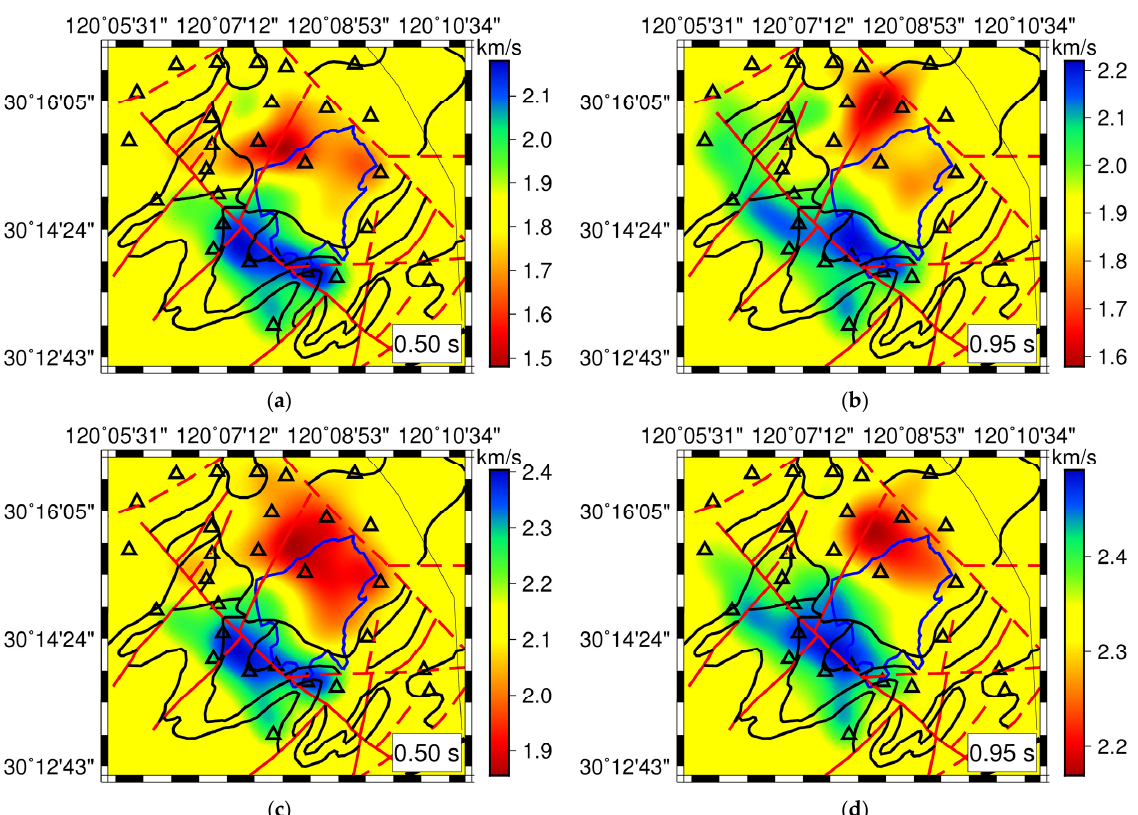
Figure 7. The top two panels ( a , b ) display the group-velocity maps, and the bottom panels ( c , d ) display the phase-velocity maps at 0.50 s and 0.95 s. Red dashed lines represent the concealed fractures, while the solid red lines represent the faults on the earth ground. Blue and black lines represent the boundary of the West Lake and strata, respectively. Triangles show the locations of seismograph